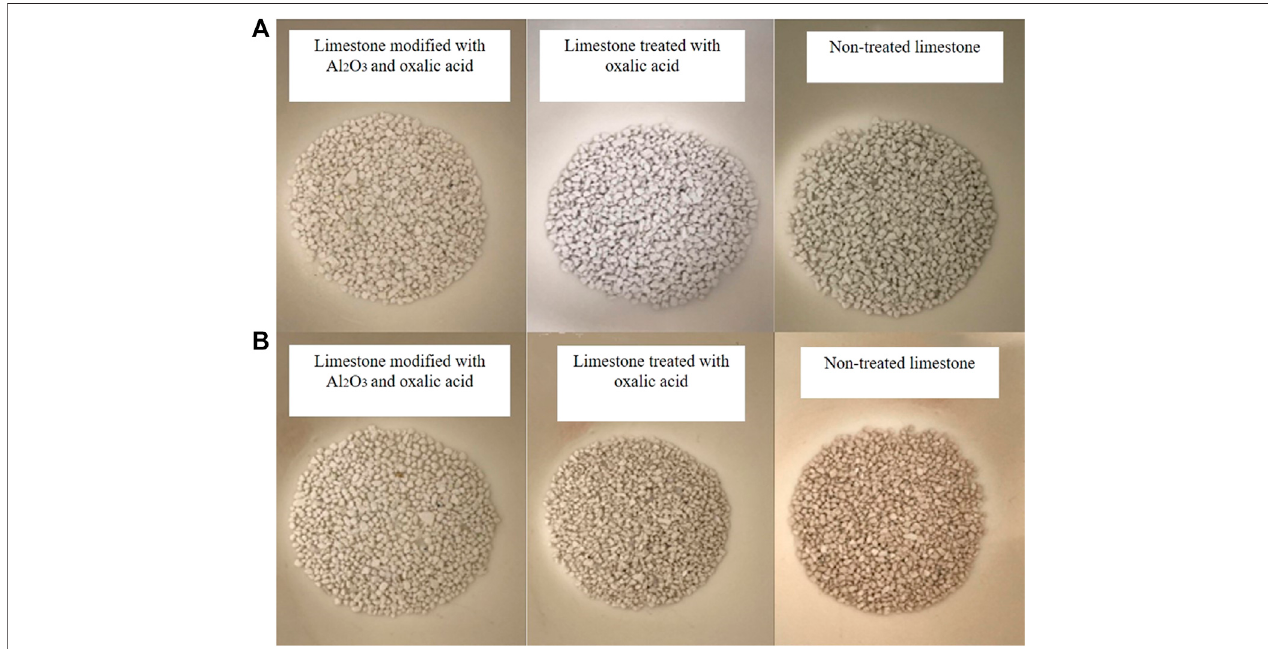
FIGURE 6 | Pelletized samples (0.8 – 1.0 mm) (A) before reaction and (B) after 100 carbonation-calcination cycles.